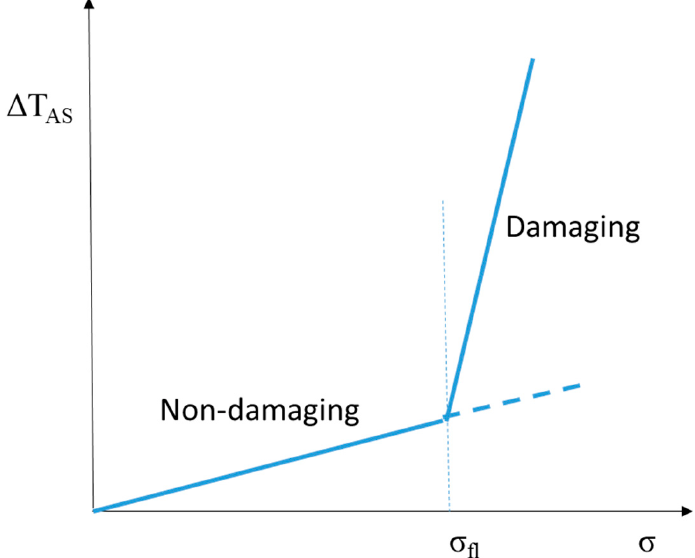
Figure 2. Typical temperature evolution curve during fatigue test.